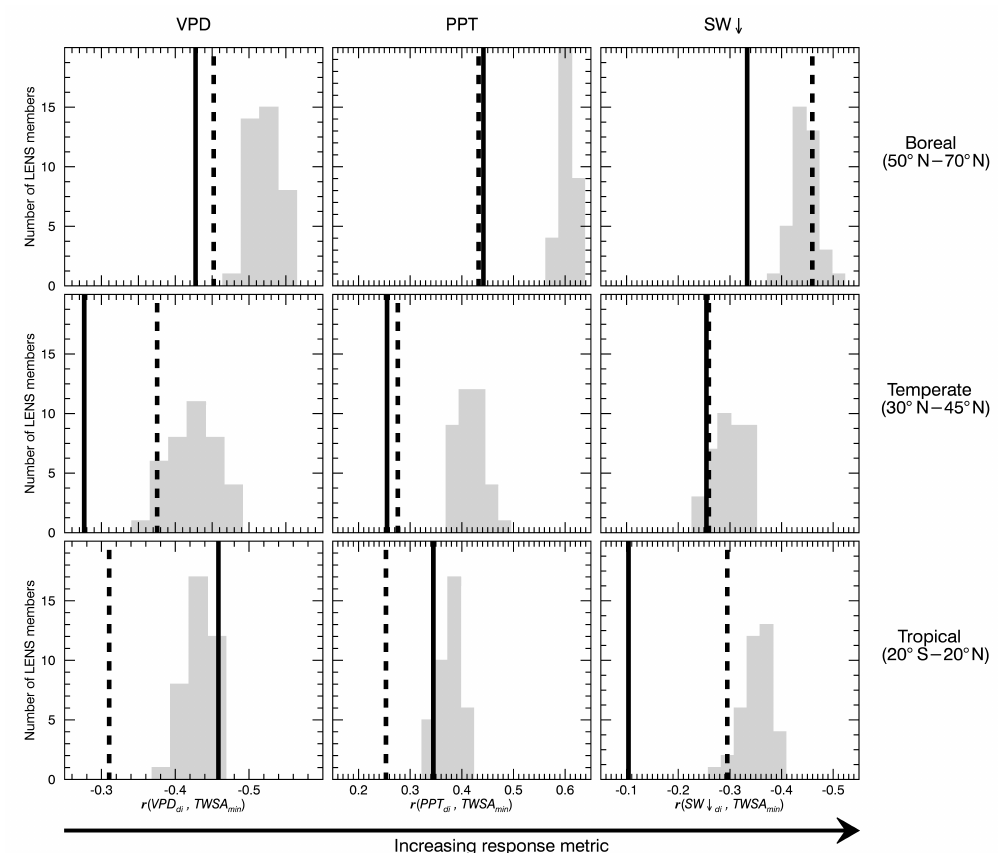
Figure 9. Ensemble histogram of response metrics from the 38 simulation in LENS (gray bars) compared to satellite observations from GRACE/AIRS/GPCP/CERES (solid black line) and the alternate set of observations from GRACE and ERA-Interim (dashed black line), averaged across land regions within different latitude